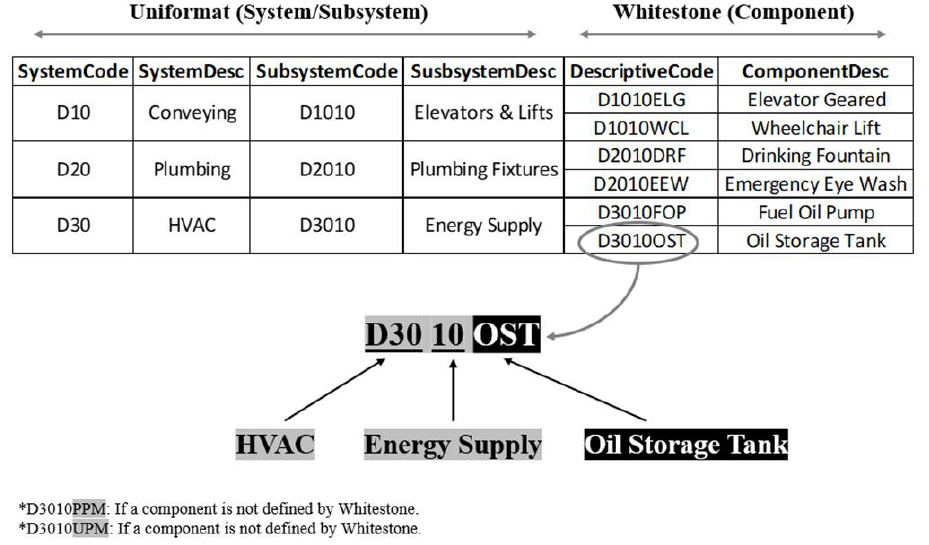
Figure 5. Facility Management Unified Classification Code (FMUCO).